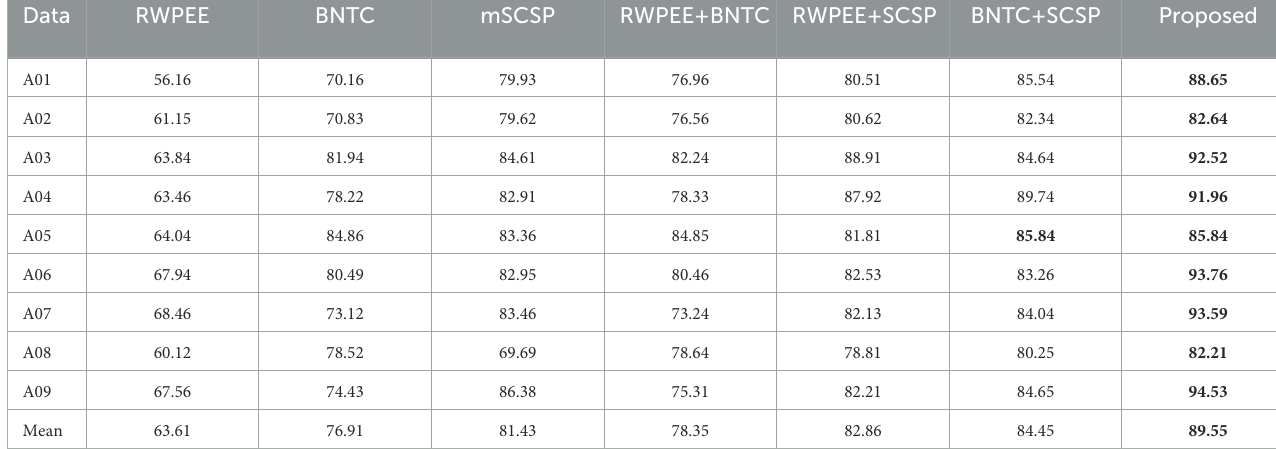
TABLE 5 The classification accuracy for different feature extraction algorithms. Data